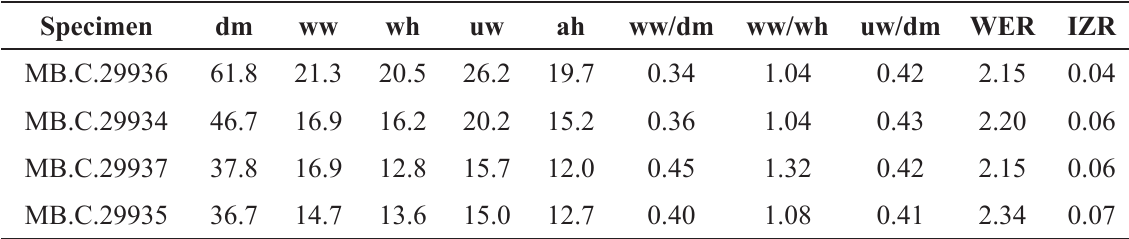
Table 19. Conch dimensions (partly estimated) and ratios of selected specimens of Paratirolites serus Korn & Ghaderi in Korn et al. (2016) from Baghuk Mountain.